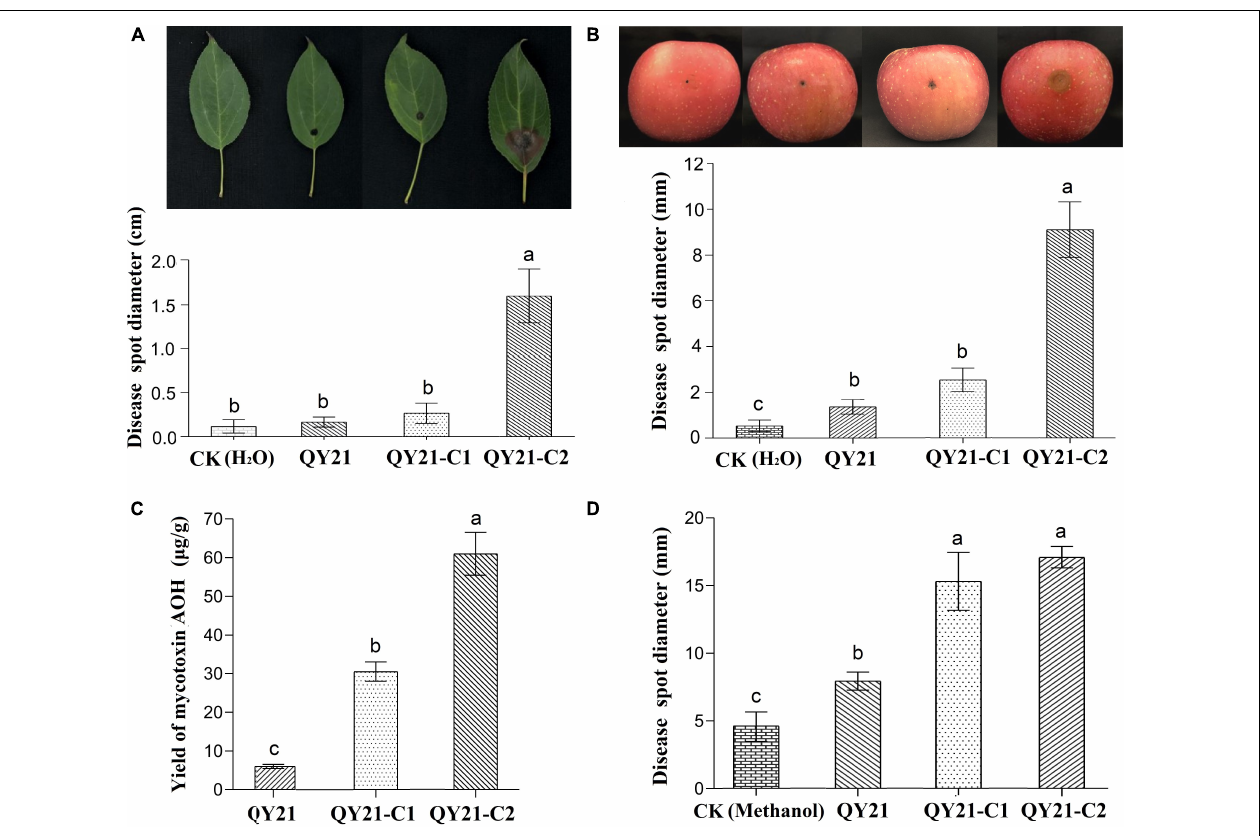
FIGURE 6 | The virulence levels of A. alternata virus-infected strain QY21 and the isogenic virus-cured strains QY21-C1 and QY21-C2. (A) Disease spot diameter and representative images showing the lesions on Malus begonia leaf induced by A. alternata strains. (B) Disease spot diameter and representative images showing the lesions on apple fruits induced by A. alternata strains. The lesions were photographed at 5 days post-inoculation. (C) The yield of the mycotoxin alternariol (AOH) of different A. alternata strains. (D) Lesion lengths on the Begonia leaf induced by the mycotoxin AOH extracted from A. alternata strains. Different letters indicate a significant difference at p < 0.05 according to the post hoc t